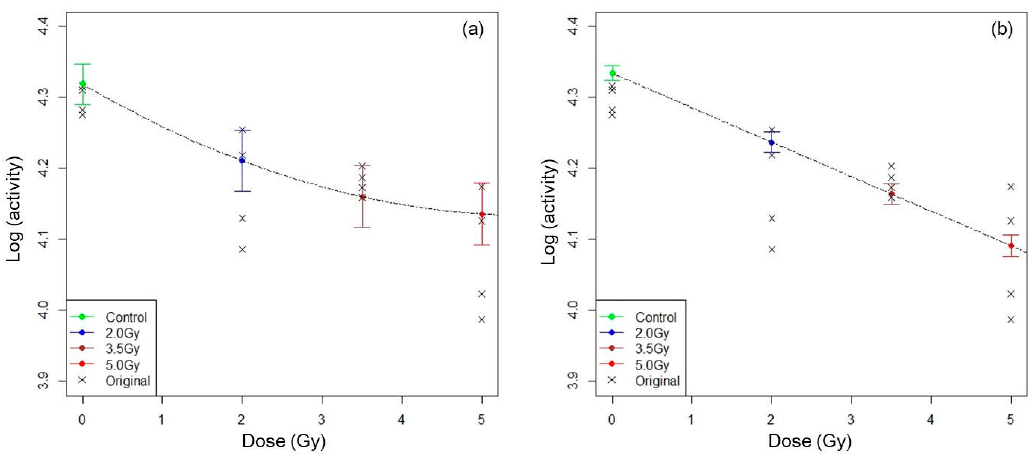
Figure 6. Fitted dose-response curves from the optimal NLMM and the optimal NLRM. The estimated magnitudes of decrease at t = 0 by dose group and their 95% confidence intervals and fitted dose-response curves with dotted line from the NLMM and the NLRM are shown in panels ( a ) and ( b ), respectively. Cross marks show observed data of individual rats. The fitted dose-response curve from the optimal NLMM was a downward convex quadratic curve.